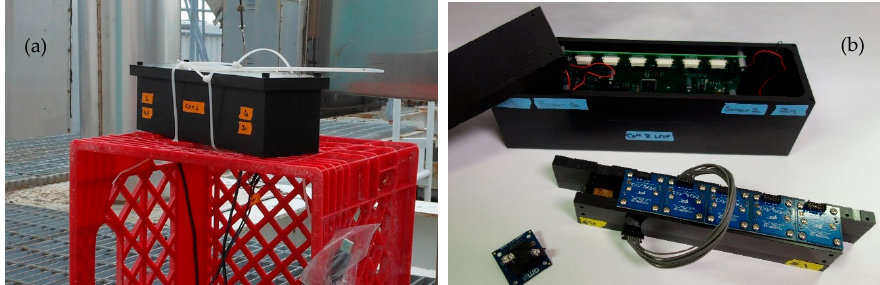
Figure 1. Images of the ABEAM-6 prototype sensor. The device includes six color-sensing breakout boards, acustomcontrolboard, fans, andwindtunnelindicatorsupportinacustomhousing. Thisdevice was used with external power and was controlled by a laptop computer. ( a ) The ABEAM-6 in an outdoor environment. ( b ) The partially disassembled ABEAM-6. Additional detail provided in the Supplementary Information, Figures S1 and